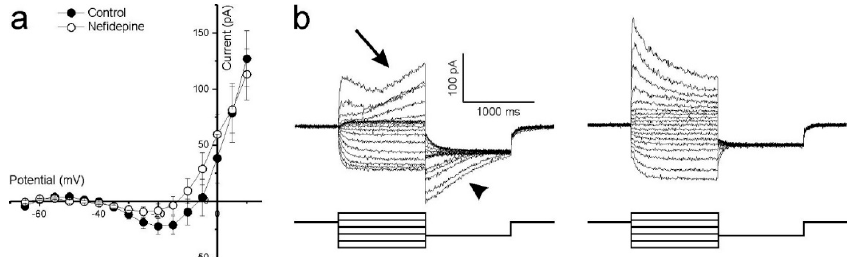
Figure 4. Ca 2+ -dependent conductances in cultured human retina cones. ( a ) The mean (± SEM, n = 5) leak-subtracted IV-relation of cones voltage clamped at − 60 mV and stepped to potentials ranging from − 100 to + 20 mV. The inward current activating around − 40 mV and peaking around − 20 mV is reduced ( p = 0.022) in amplitude by nifedipine, an L-type Ca 2 + channel blocker. ( b ) Whole cell currents of a representative cone, clamped at − 40 mV then stepped to potentials ranging from − 80 mV to + 20 mV for 1 s before being stepped back to − 60 mV for 1 s. The slowly developing outward current occurring at more depolarized potentials (left-arrow) and the associated dissipating current when these potentials are stepped back to − 60 mV (left-arrowhead) are both absent in the presence of the Ca 2 + -dependent Cl − -current blocker, niflumic acid (right). Cones in other vertebrate retinas normally express a large Ca 2+ -dependent Cl - -current (I Cl(Ca) ) [46], whose activation depends on the intracellular Ca 2+ -concentration. As cone intracellular Ca 2+ concentration dynamics are relatively slow [46], a characteristic feature of the cone I Cl(Ca) is its slow activation and inactivation time constants. Cones in the cultured human retinas also display currents with these features as Figure 4b (left) shows. Here, cones were stepped from a − 40 mV holding potential to values between − 80 mV and +20 mV for 1000 ms to give I Cl(Ca) time to develop. The potential was then stepped to − 60 mV to inactivate I Ca and held for 1000 ms to give I Cl(Ca) time to discharge. At more depolarized potentials where I Ca is near maximal, an outward current starts slowly developing approximately 300 ms after the onset of the command potential (arrow). When these potentials step back to − 60 mV, a slowly dissipating tail-current occurs (arrowhead). Neither of these two slow currents occurred in the presence of 100 µM niflumic acid, an I Cl(Ca) blocker (Figure 4b, right).